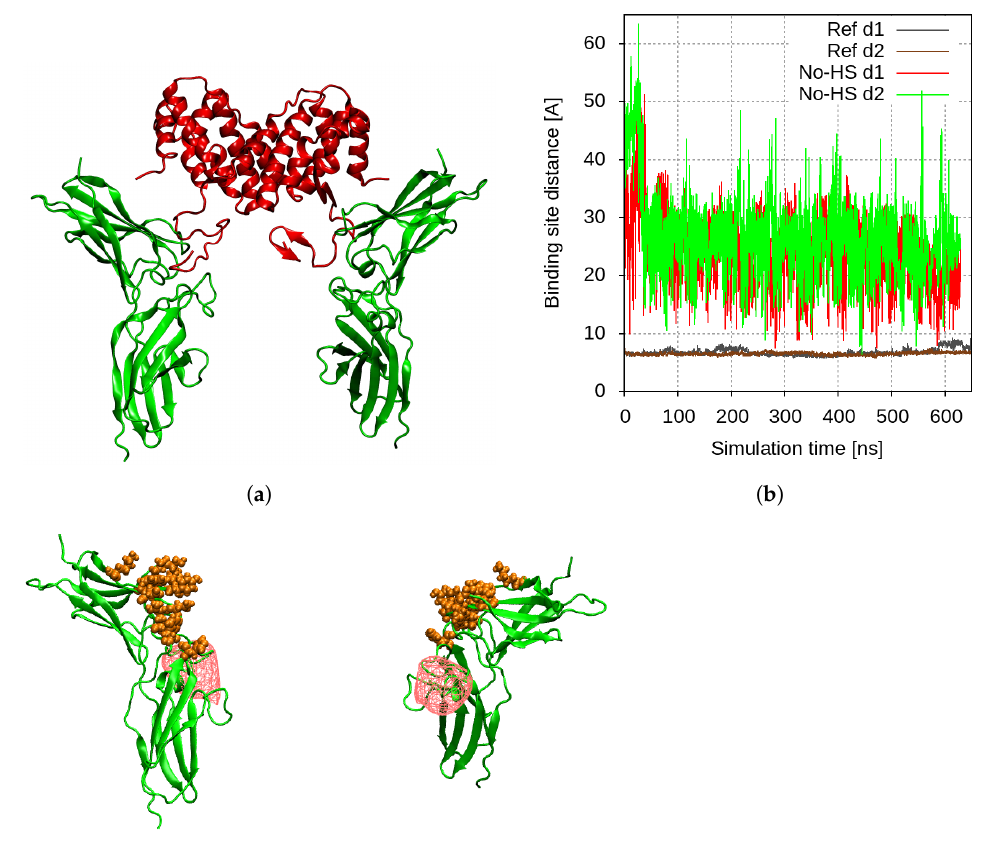
Figure 2. ( a ) Final conformation of the hIFN γ –hIFNGR1 binding simulation. The cytokine and the receptor subunits are presented in red, resp. green cartoons; ( b ) time evolution of the COM distances d 1 and d 2 between the binding sites in the hIFN γ and hIFNGR1 molecules with no HS-derived oligosaccharides present; ( c ) localized negative charge density at the “knees” of the two hIFNGR1 subunits, shown in red wireframe; hIFN γ -binding sites are presented in orange